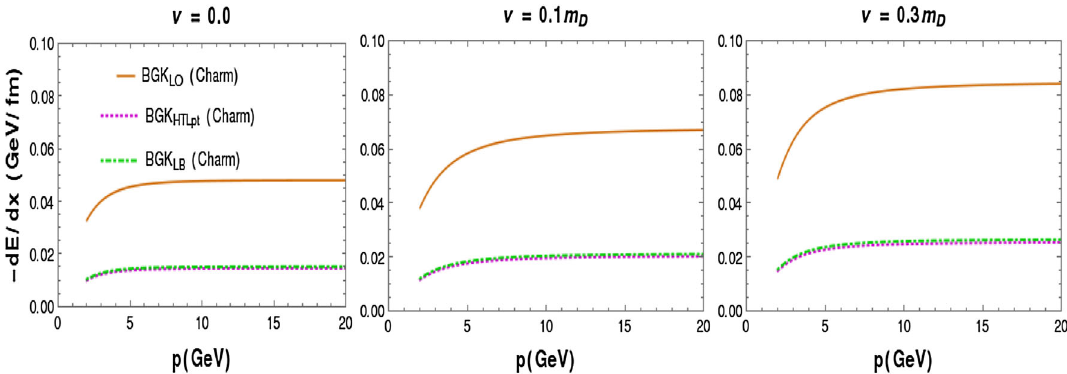
Fig. 1 Energy loss of the charm quark ( m = 1 . 8 GeV ) for various values of ν at T = 2 T c and different Equations of State (EoSs)